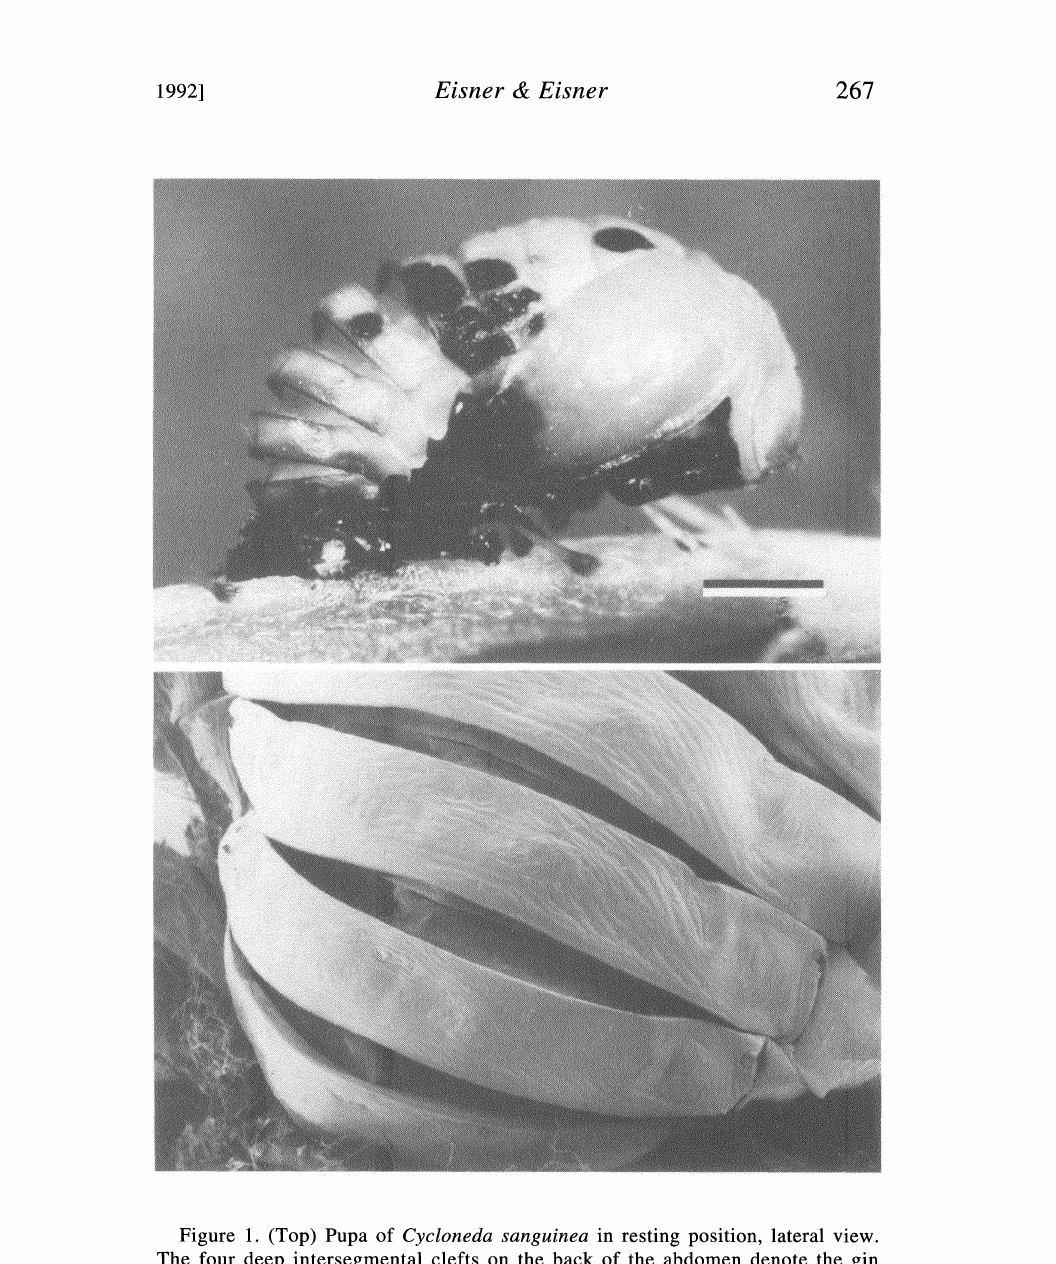
Figure 1. (Top) Pupa of Cycloneda sanguinea in resting position, lateral view. The four deep intersegmental clefts on the back of the abdomen denote the gin traps. (Bottom) Same, surface view of gin traps (anteriormost gin trap is only partly shown) (scanning electronmicrograph). Reference bar, top figure